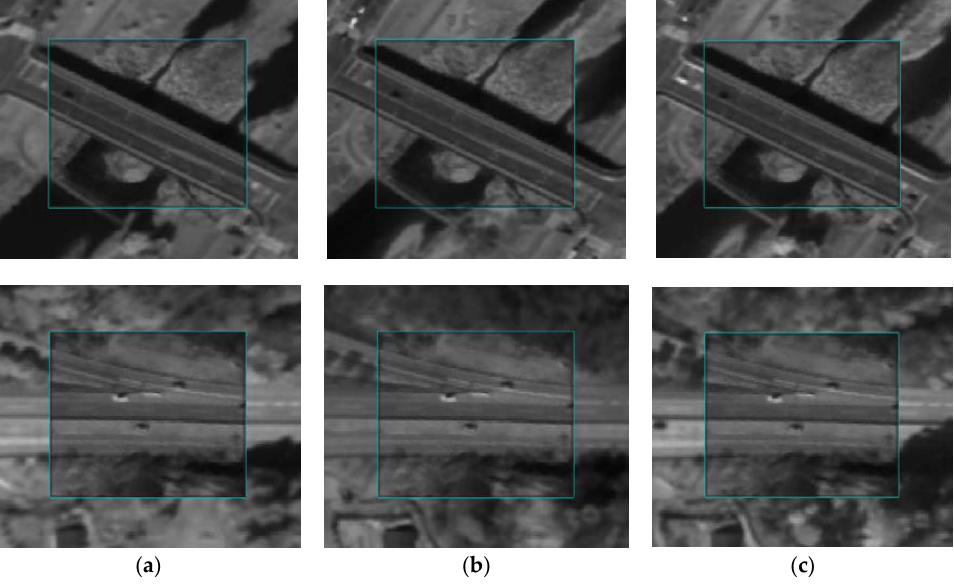
Figure 10. Visual inspection of co ‐ registration results focusing on multi ‐ temporal images: ( a ) K3 ‐ 1 and K3 ‐ 3, ( b ) K3 ‐ 1 and K3 ‐ 4, and ( c ) K3 ‐ 1 and K3 ‐ 5. Table 3. Accuracy assessment of georegistration and co ‐ registration results. RECC—relative edge cross ‐ correlation; RNCC—registration noise ‐ based cross ‐ correlation. Reference Image